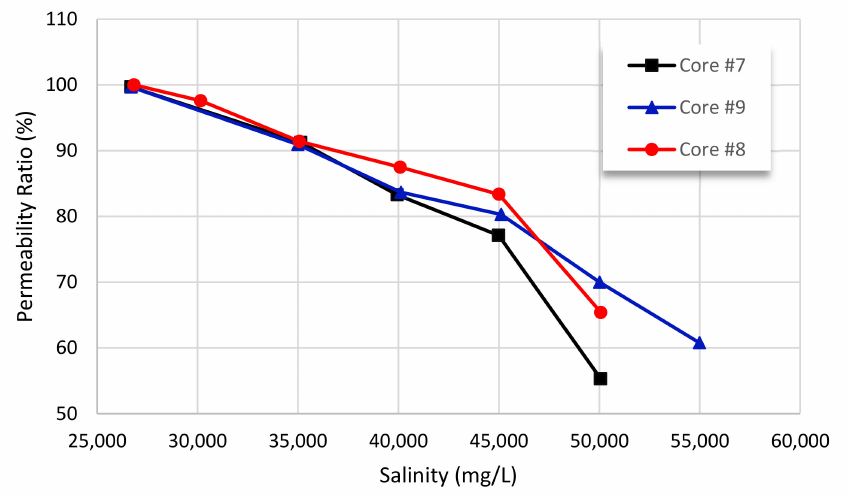
Figure 13. Impact of the salinity of synthetic pore fluid on the permeability of Huangliu sandstone reservoir cores